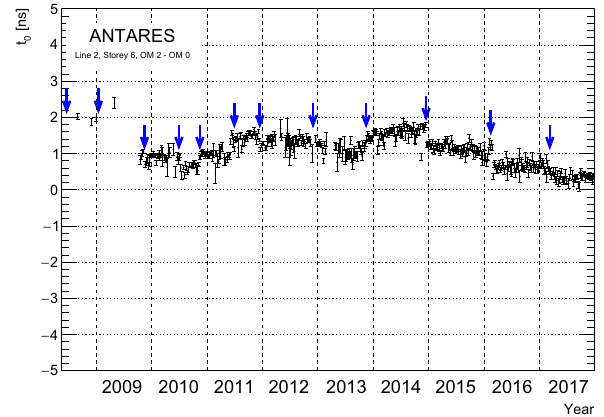
Fig. 6 Fitted time offset as a function of time for one OM pair (Line 2, Storey 6, OM 2 - OM 0). The blue arrows indicate the periods in which high voltage tuning of the PMTs has been performed